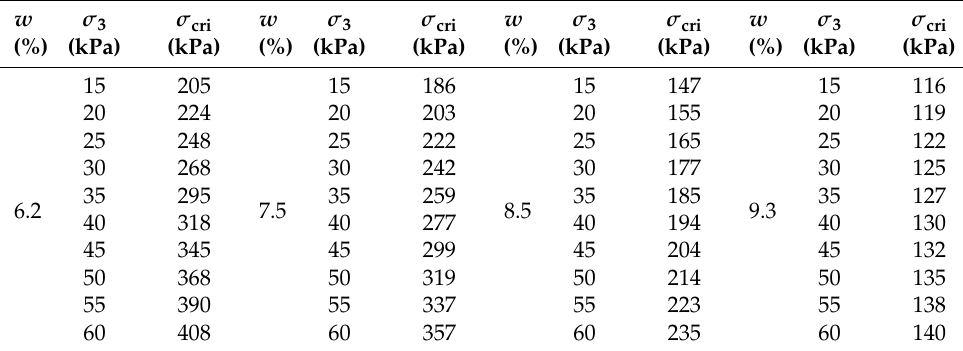
Figure 9. Output results of β using the trained BP neural network. Table 3. Evaluated critical dynamic